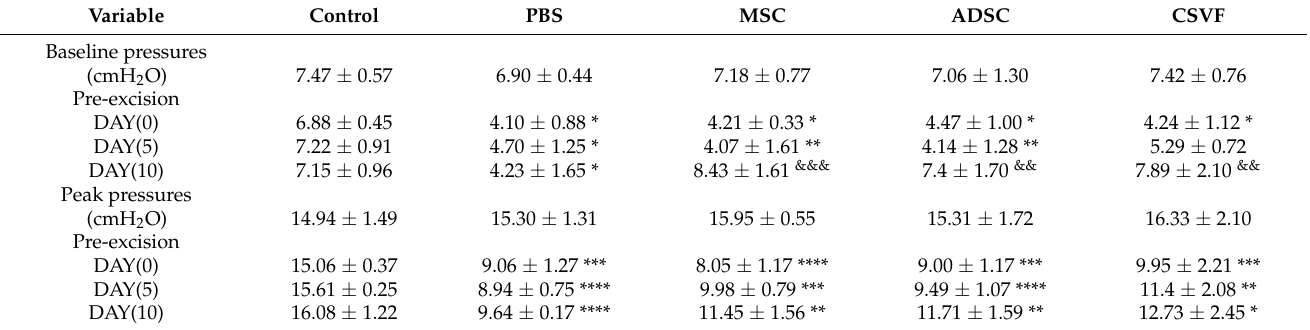
Figure 3. Anal pressure of control, PBS, MSC, ADSC and CSVF groups after modeling and after 5 and 10 days of treatment. ( A ) The first row shows the anal pressure graphs of 70 s recorded in control, PBS, MSC, ADSC and CSVF groups after modeling, and the anal pressure decreased significantly after modeling; the second row shows the anal pressure graphs of 70 s recorded in each group after 5 days of treatment; the third row also shows the anal pressure graphs of each group after 10 days of treatment. ( B ) Percentage of anal pressure basal value (a), anal pressure peak (b) in different treatment groups normalized to pre-treatment healthy controls. Data in each bar graph are expressed as mean ± standard deviation. An *, **, *** or **** without a horizontal line indicates a statistical difference in comparison to the control group, and an *, ** or *** with a horizontal line indicates a statistical difference between the groups at the horizontal ends. Significant differences between groups were expressed as **** p < 0.0001, *** p < 0.001, ** p < 0.01, and * p < 0.05. Table 1. Mean ± standard deviation of anal pressure basal and peak values before modeling and after 5 days and 10 days of treatment in Control, PBS, MSC, ADSC, and CSVF groups.